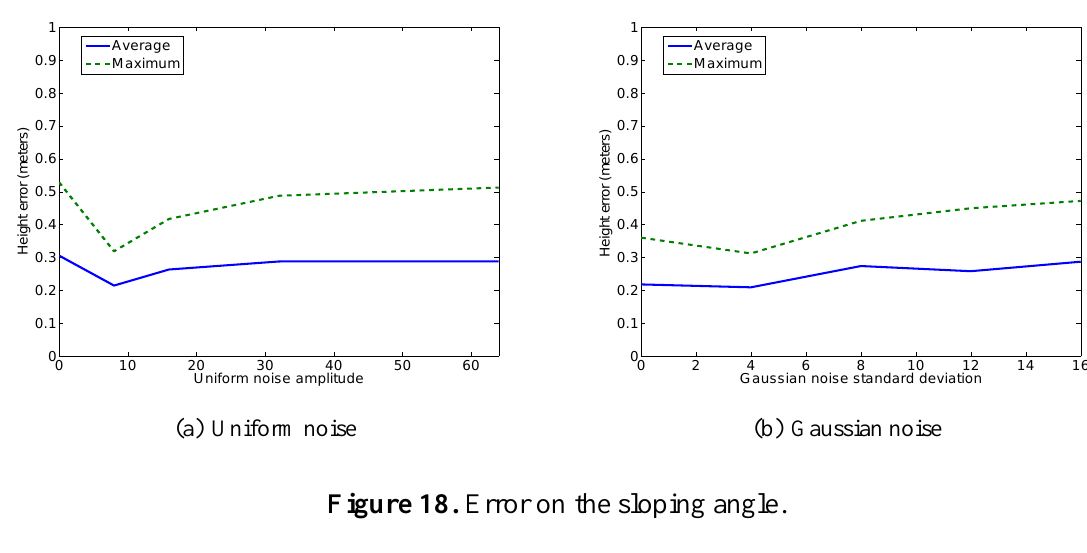
Figure 17. Error on the facet height.